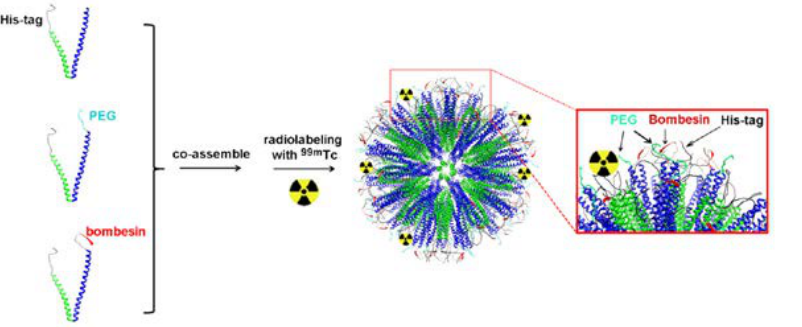
Figure 6. GRPR binding motif can be incorporated in the structure of the building blocks of the nanostructure prior to its assembly. Adapted from ref. [66].